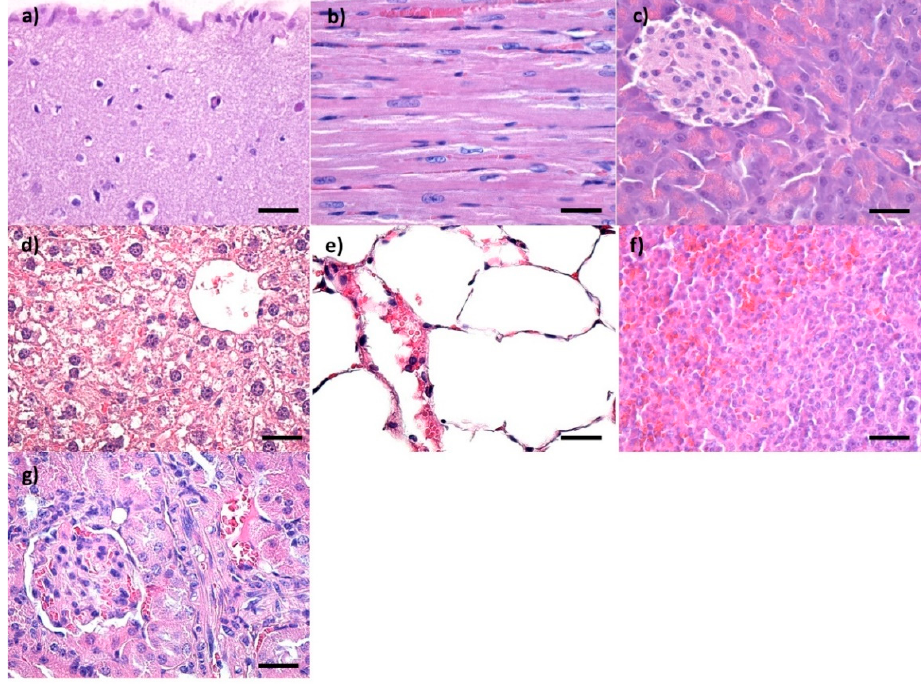
Figure 3. Cross-section through ( a ) brain, ( b ) myocardium, ( c ) pancreas, ( d ) liver, ( e ) lungs, ( f ) spleen, and ( g ) kidney from control mice injected with saline solution and harvested at 10 days after intravenous administration; normal morphology; Hematoxylin–Eosin staining; 400× magnification, scale bar 50 μ m.